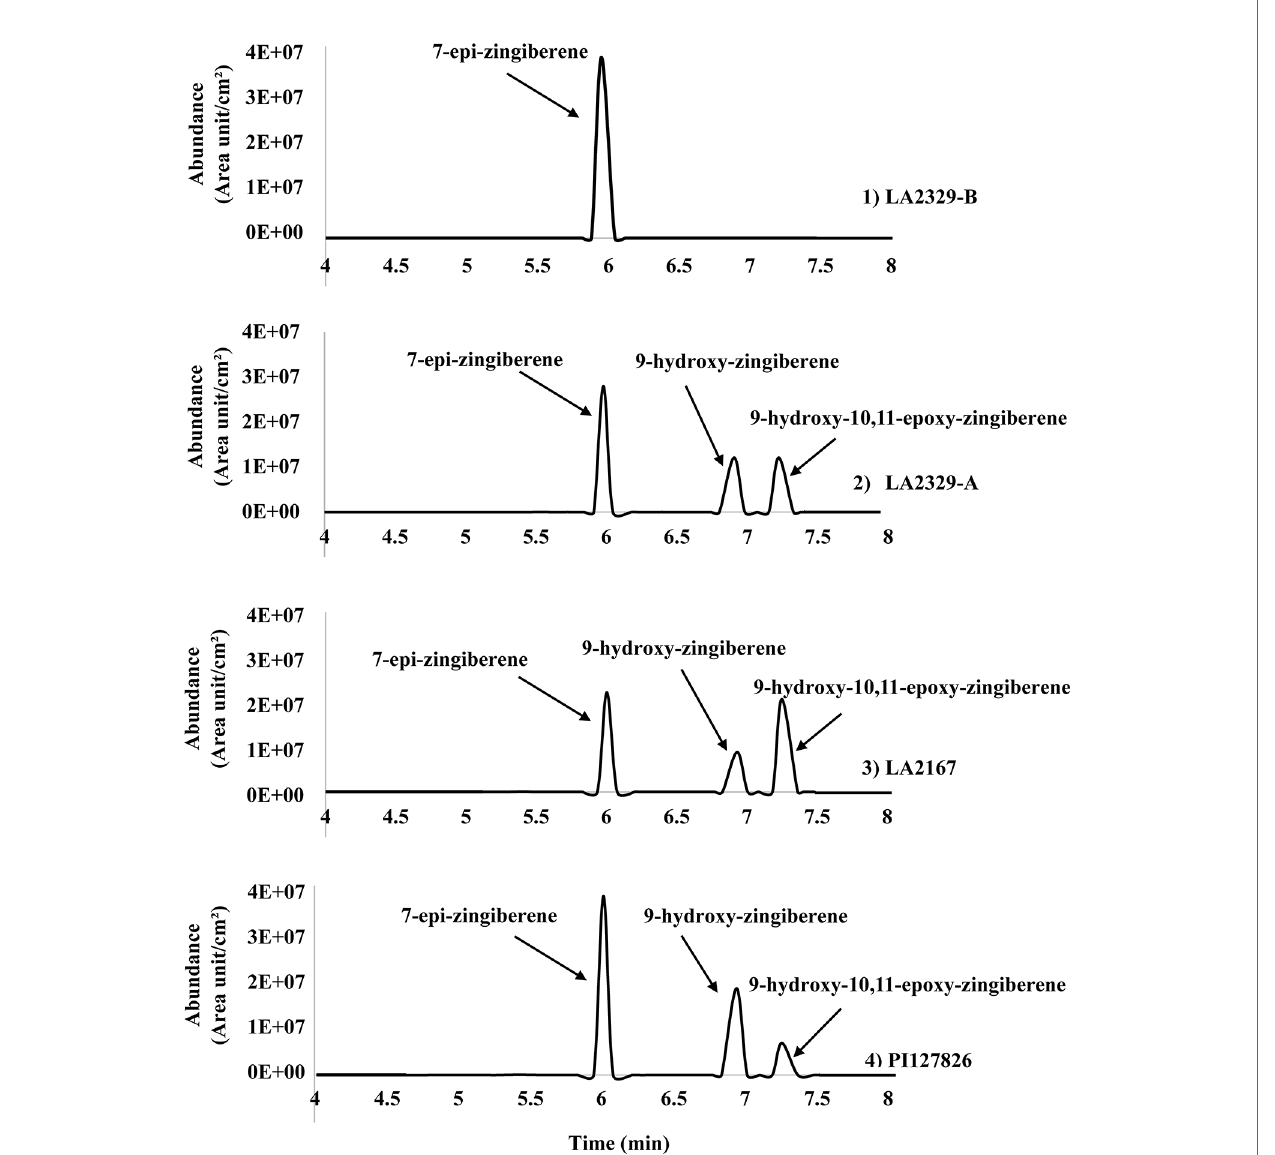
FIGURE 1 | Chromatogram (GC-FID) of n -hexane lea fl et wash from: (1) the LA2329-B chemotype showing a single major component at retention time of 6.00 min; (2) the LA2329-A chemotype showing three major components at retention times of 6.00, 6.91, and 7.23 min; (3) LA2167 showing three major components at retention times of 6.00, 6.91, and 7.23 min; (4) PI127826 showing three major components at retention times of 6.00, 6.91, and 7.23